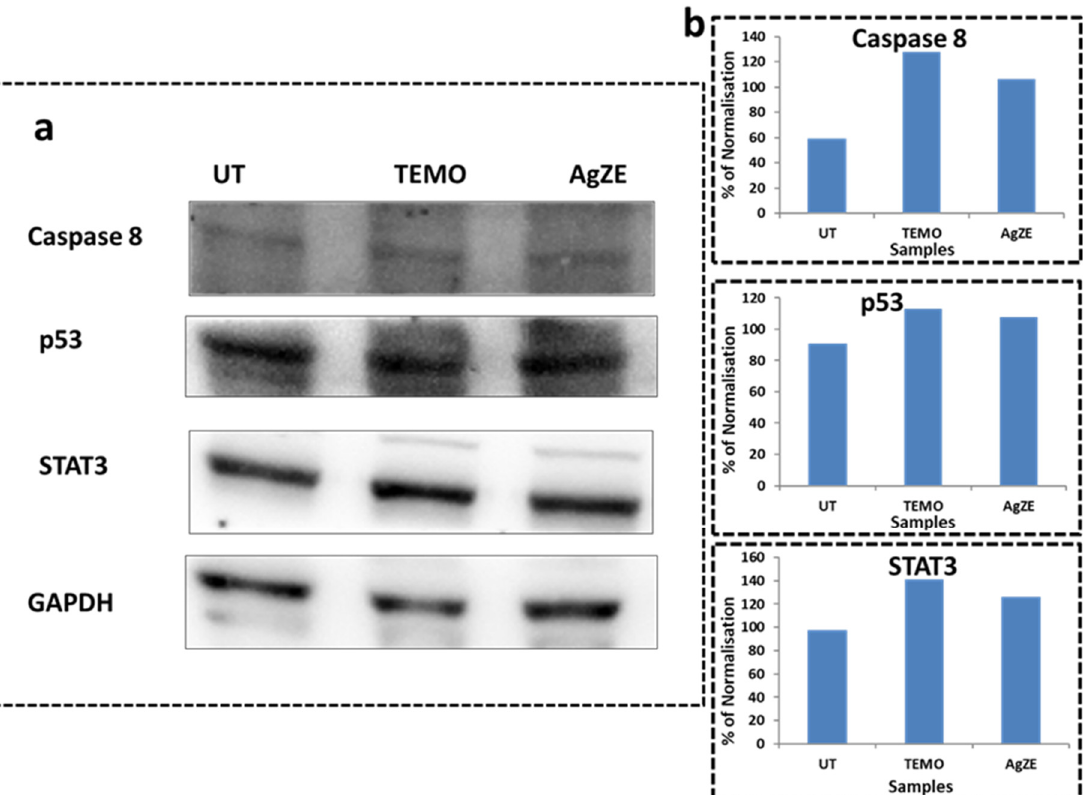
Figure 7. Western blot analysis of the U-87 cell lysates where the groups are untreated (first column), temozolomide: TEMO, positive control (second column), and AgZE (third column) with blots of ( a ) caspase 8 (first blot), p53 (second blot), STAT3 (third blot), and GAPDH (fourth blot), ( b ) graphical representation of quantification of Western blots using Image J analysis. Upon treatment with AgZE, U-87 cell protein lysates show upregulation of caspase-8 as well as p53 with slight upregulation of STAT3 compared to untreated samples. GAPDH is used as loading control.